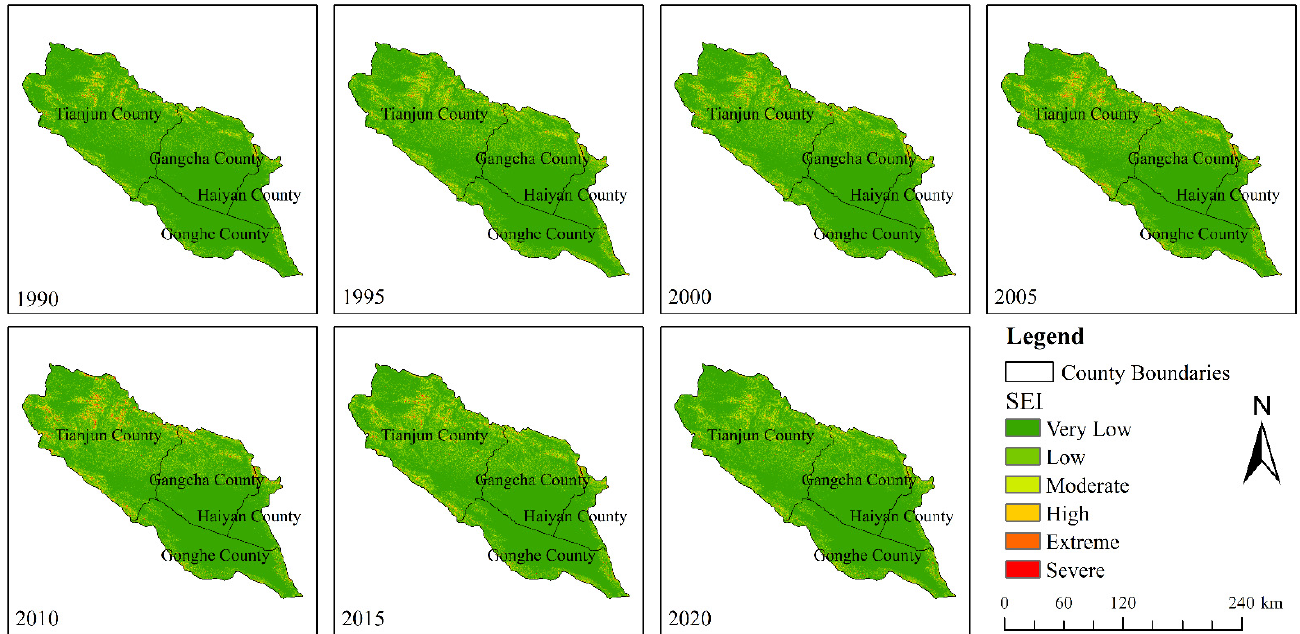
Figure 6. Grading map of SEI in the QLB from 1990 to 2020. Table 4. The transfer matrix of SEI in the QLB in 1990–2005